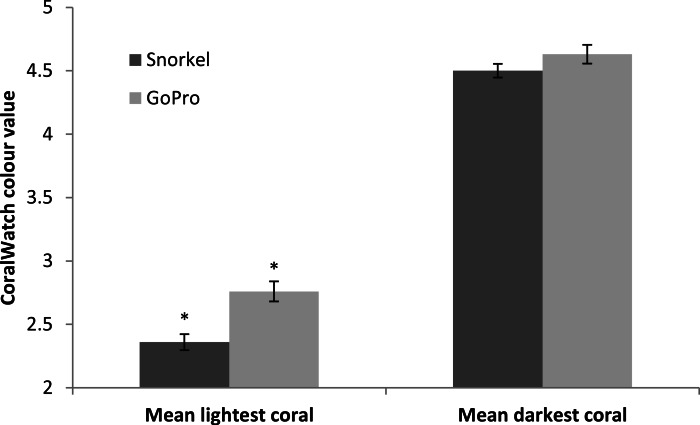
Mean Coralwatch values.Mean ± 1. S.E. lightest and darkest CoralWatch colour chart results using either traditional snorkel surveys or GoPro photogrammetry. Asterisks represent means that are significantly different.